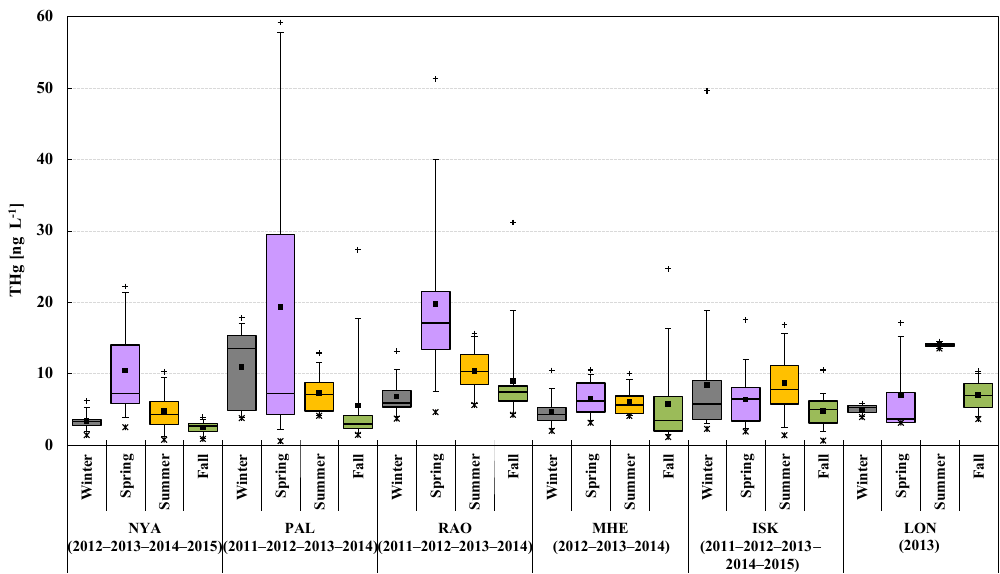
Figure 3. Seasonal distribution of volume-weighted THg concentration in precipitation at the European GMOS sites from 2011 to 2015. Each box includes the median (midline), mean ( (cid:4) ), 25th and 75th percentiles (box edges), 5th and 95th percentiles (whiskers), minimum ( ∗ ), and maximum ( +